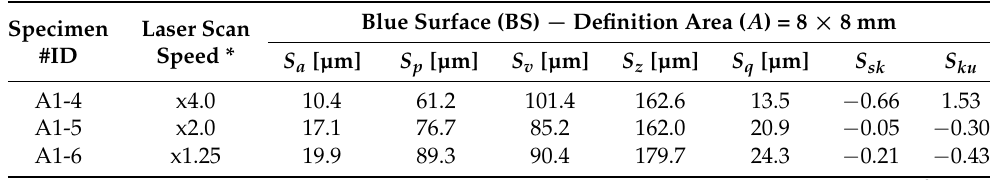
Table 11. Surface texture parameters results increasing the laser scanning speed: blue surface ( BS ). Specimen